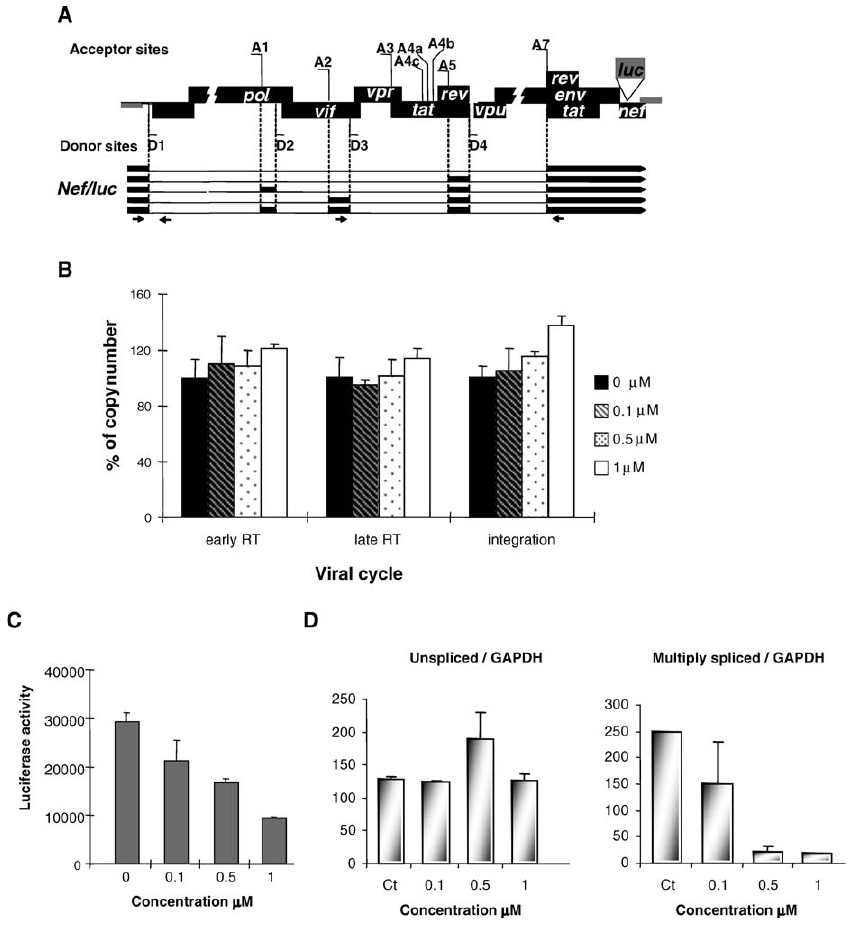
Figure 5. Identification of the Step in HIV Life Cycle Inhibited by IDC16 HOS-CD4 þ -CCR5 þ cells were exposed to various concentrations of IDC16 and infected with D env-defective virions containing the luciferase gene (A). The efficiency of the reverse transcription and of the integration was evaluated by quantifying early and late reverse transcriptase products and the number of copies of integrated HIV DNA, respectively (B). Forty eight hours later, intracellular luciferase activity was measured as a marker of spliced viral RNA expression (C). The same infected cells treated with 0.1 l M, 0.5 l M, or 1 l M of IDC16 were used to examine the relative amount of unspliced precursor and multiply spliced HIV-1 RNA. Real-time RT-PCR was used to rigorously quantify the changes in unspliced (D, left panel) and multiply spliced (D, right panel) HIV-1 RNA levels after IDC16 treatment. The values are the average of two independent experiments and the level of expression is normalized with that of the internal control gene ( GAPDH ). The error bars indicate standard deviations. Arrows in (A) indicate the position of primers to amplify unspliced precursors (La 8.1 and La 9) and multiply spliced (P659 and P413MOD) HIV RNA species according to Brussel and Sonigo